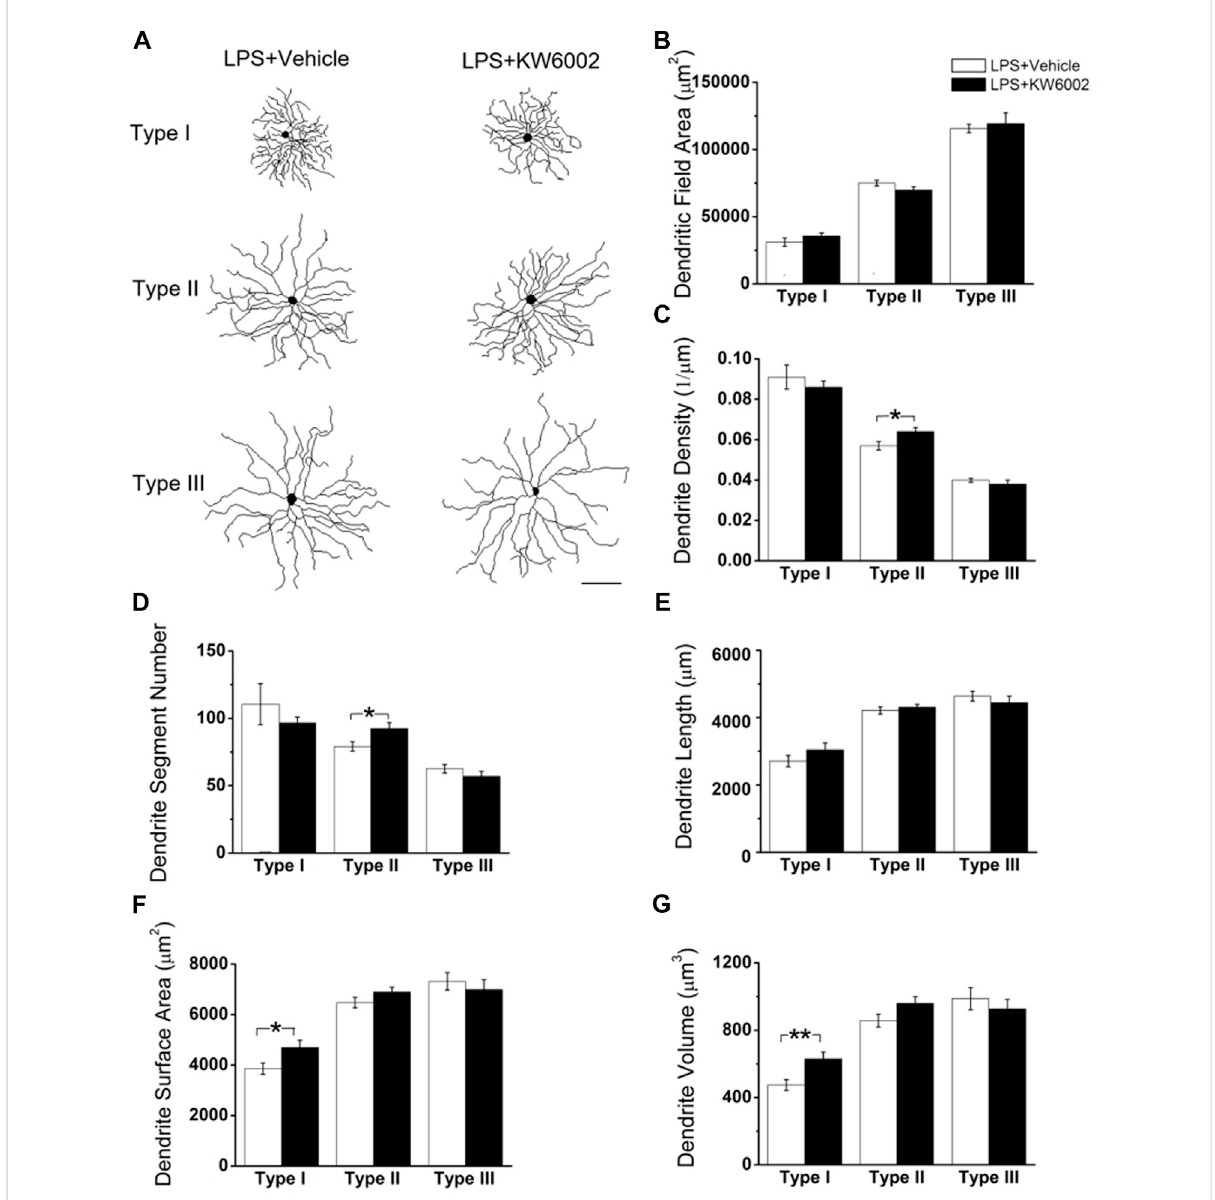
FIGURE 7 The effect of KW6002 on the dendritic morphology of RGCs after neonatal LPS exposure. (A) Representative 3D reconstructions of the three RGC types from the vehicle-treated and KW6002-treated mice after neonatal LPS exposure. (B – G) Comparative analysis of dendritic fi eld area (B) , dendrite density (C) , dendrite segment number (D) , dendrite length (E) , dendrite surface area (F) and dendrite volume (G) in each RGC type between the vehicle-treated and KW6002-treated group after neonatal LPS exposure. Data represent mean ± SEM. * p < 0.05; ** p < 0.01. Scale bar, 100 μ